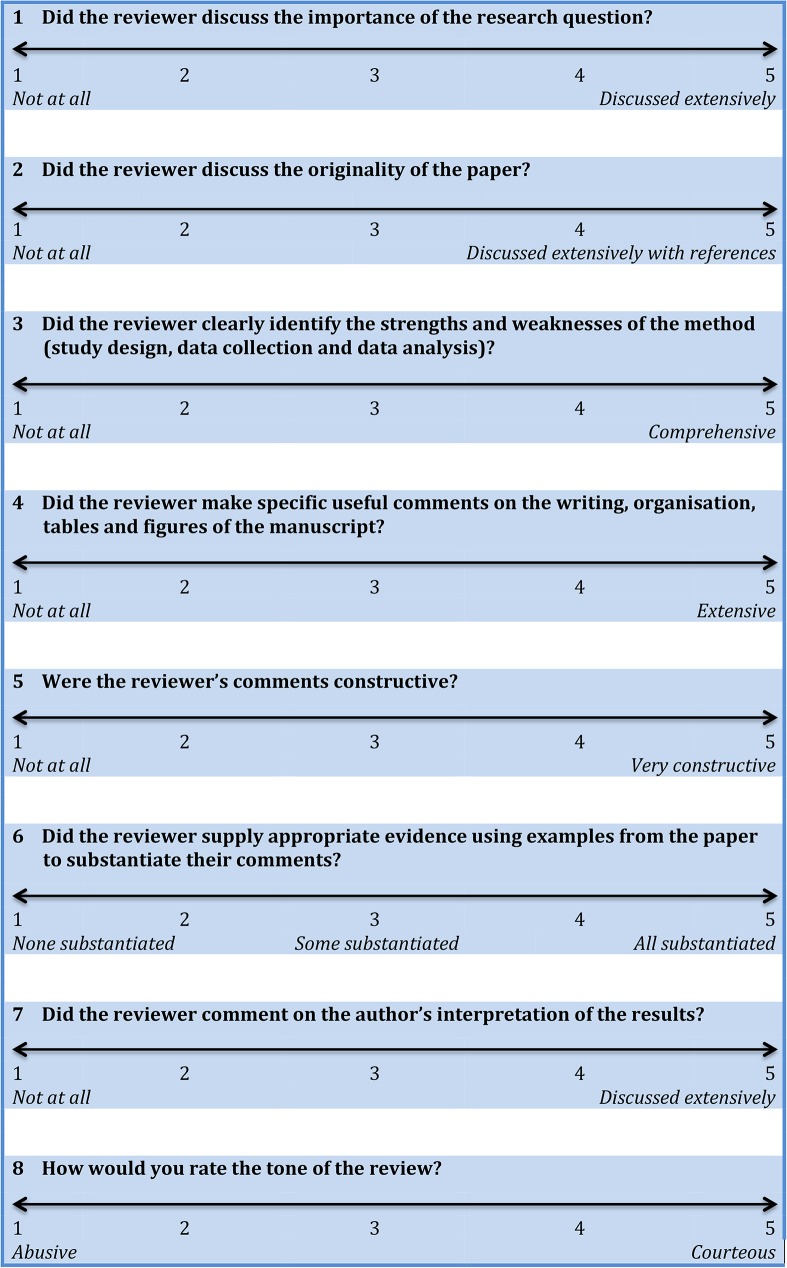
Review quality instrument by van Rooyen et al. [23].